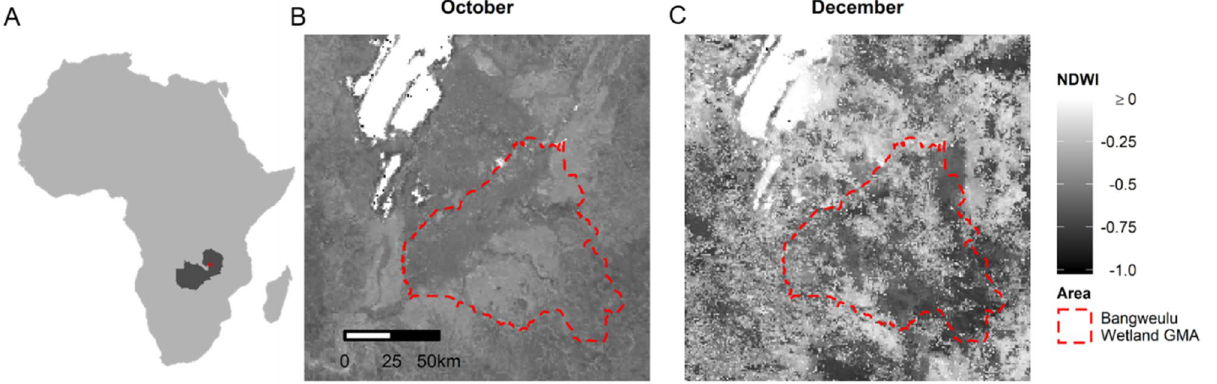
Figure 5. (A) Location of the Bangweulu Wetlands Game Management Area (in red) within Africa (light grey) and Zambia (dark grey); (B) changes in NDWI between the start of October (week between 30/09/2015 and 07/10/2015), just prior to the start of the rainy season and (C) the end of December (week between 19/12/2015 and 26/12/2015), which is during the rainy season. The red dashed line indicates the border of the Bangweulu Wetlands Game Management Area. Satellite imagery obtained from MODIS Terra Surface Reflectance (https:// doi. org/ 10. 5067/ MODIS/ MOD09 A1.